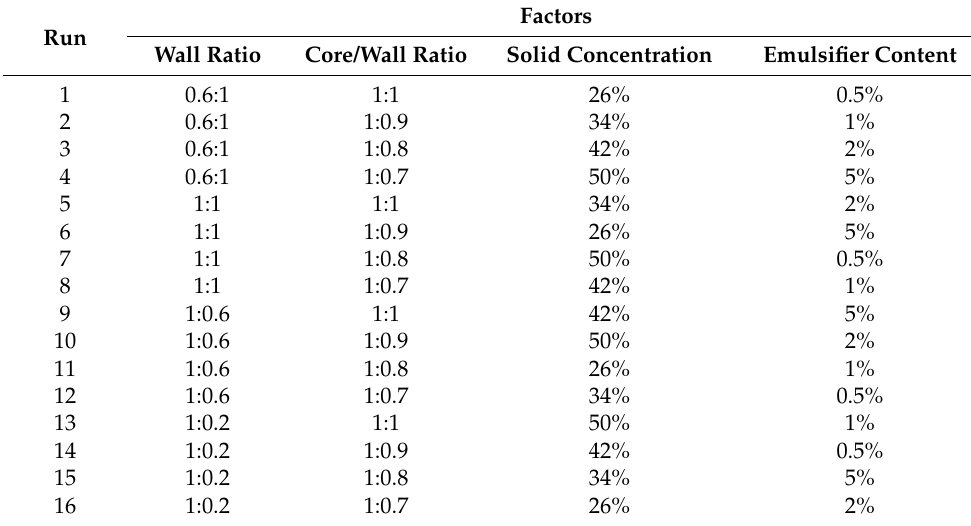
Table 2. Design of orthogonal L 16 (4) 4